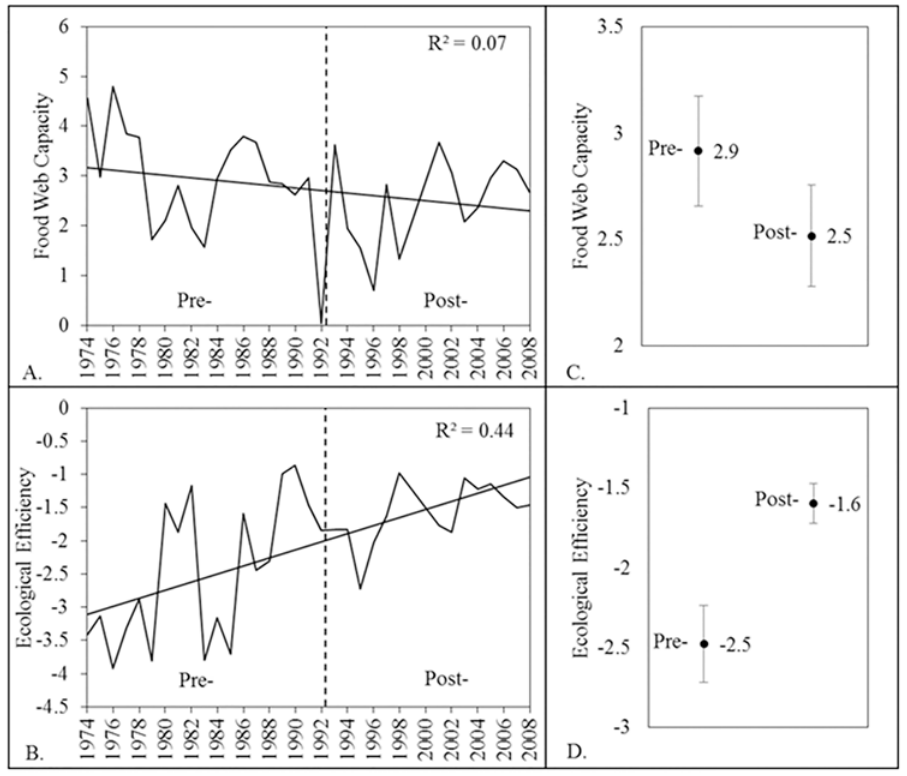
Fig 4. Annual trends of functional food web indices from 1974 – 2008. (A) food web capacity as a proxy for the centered spectral elevation of annual CSS, (B) ecological efficiency indexed by the regression slope of annual CSS, (C) mean food web capacity during early and late time periods including standard error, and (D) mean ecological efficiency during early and late time periods including standard